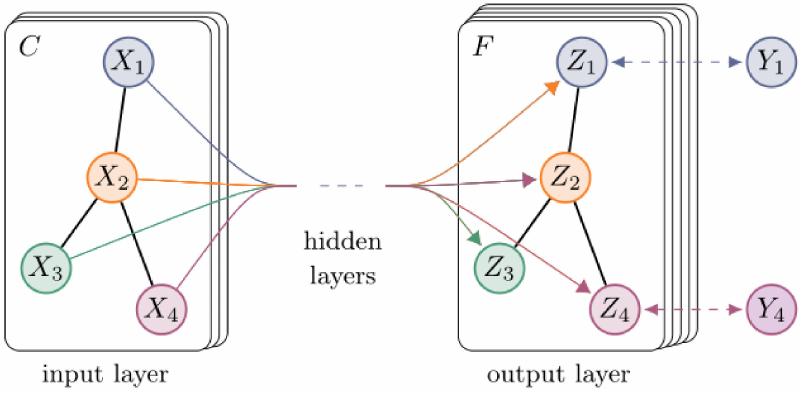
Figure 9. Graph convolutional neural networks